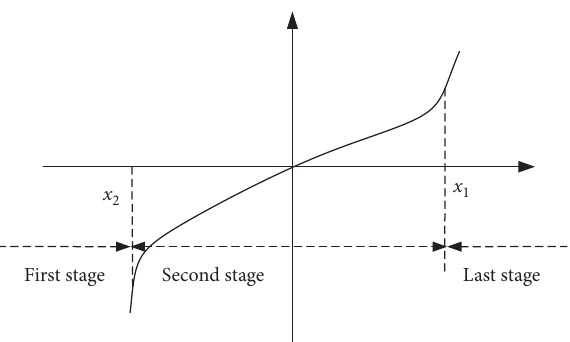
Figure 7: Fitting of the force-displacement relation.